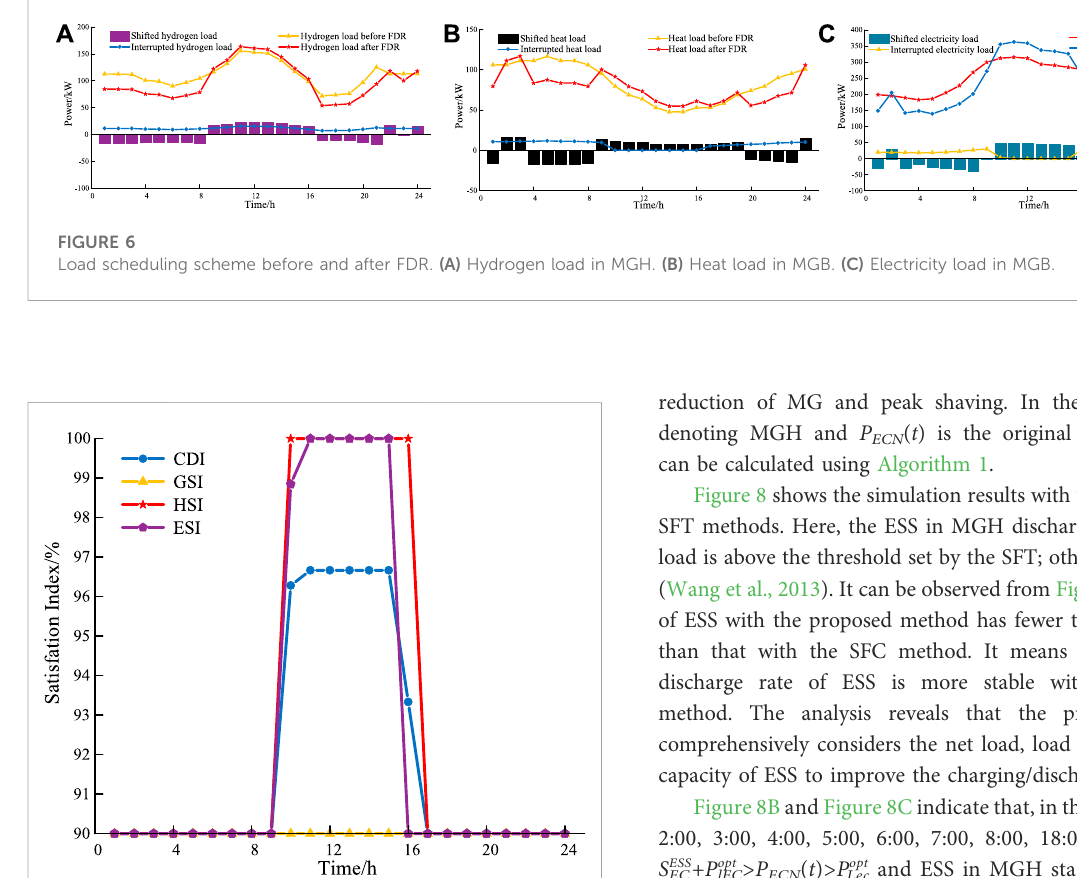
FIGURE 7 CDI of the MMG and satisfaction indexes of each